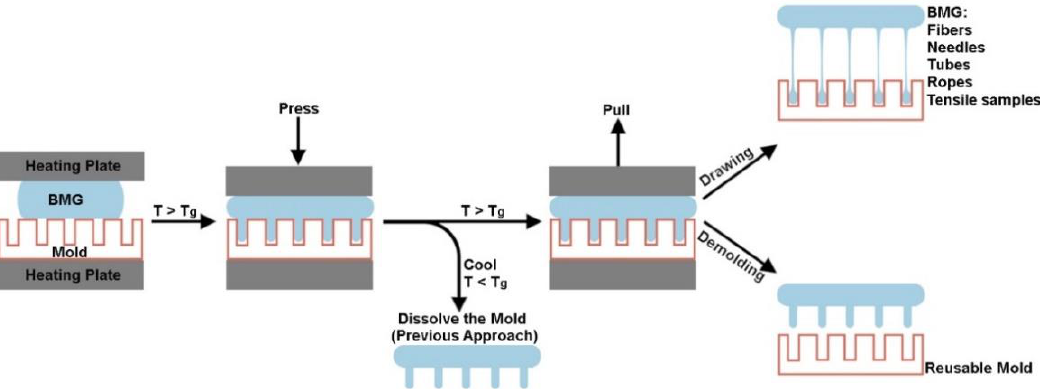
Figure 1. Schematic illustration of thermoplastic embossing and drawing of BMGs. The BMG is pressed against a mold at temperature above T g . The mold is etched out after cooling to release the BMG in conventional approach. In drawing, the BMG is pulled apart from the mold above T g . Depending on the pulling speed a complete demolding or elongation of BMG features can be achieved.